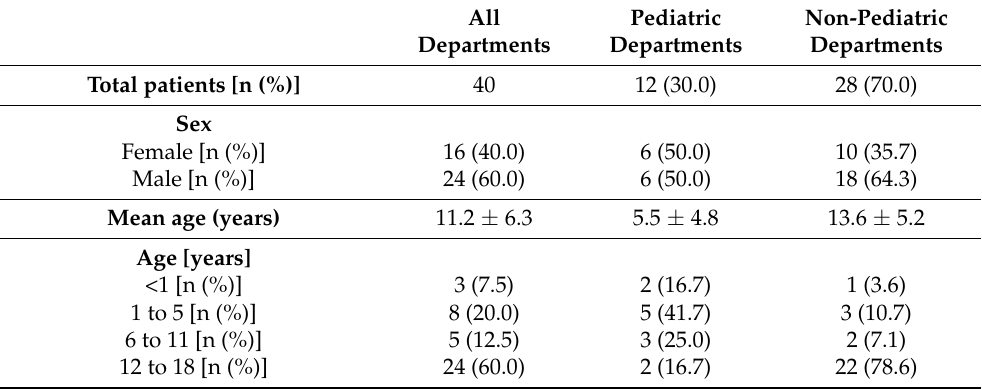
Table 8. Patient characteristics (subgroup of deceased